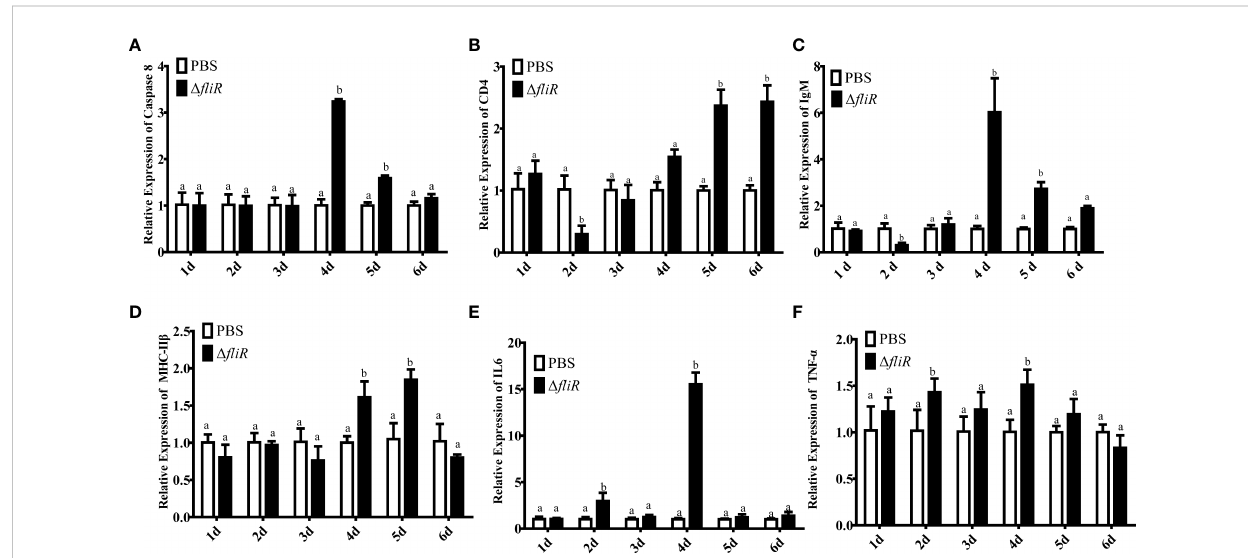
FIGURE 9 The expression levels of immune-related genes in grouper spleen after immunization were detected by qRT-PCR for (A) Caspase8 , (B) CD4 , (C) IgM , (D) MHC-II b , (E) IL6 , (F) TNF- a . Groups with notable differences are labeled with different letters above the bars. b -actin was chosen as the reference gene. Data are shown as mean ± SEM (n =